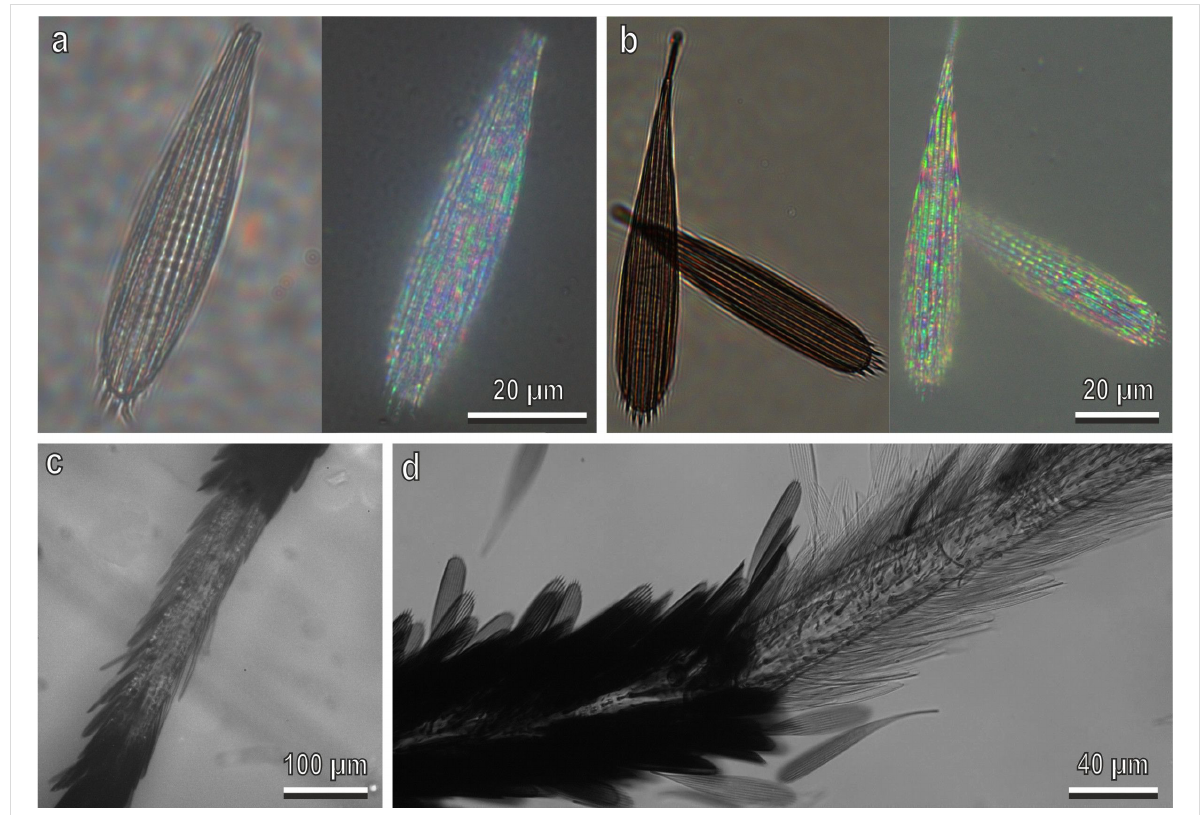
Figure 5: Tarsal black and white scales of Aedes albopictus female in a light microscope. (a) Dry white scales under transmitted (left) and reflected (right) light; (b) Dry black scales under transmitted (left) and reflected (right) light. (c) White and black scales immersed in oil under reflected light. Note that the white scales do not appear white, but rather transparent, while the black scales appear dark due to the presence of a certain amount of dark pigment in the cuticle. (d) White and black scales immersed in oil under transmitted light.